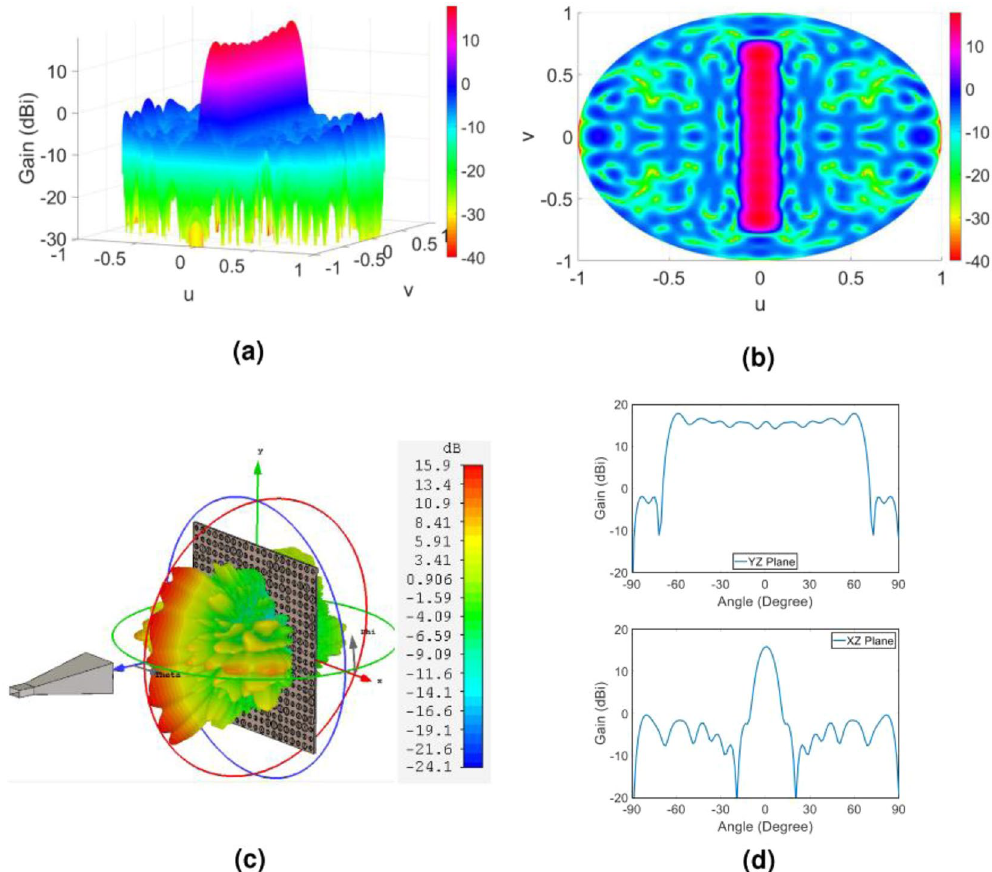
Figure 8. ( a ) Three-dimensional and ( b ) two-dimensional display of theoretical results of the object wave in the far field, ( c ) three-dimensional demonstration of the full wave simulation result of the object wave in CST software, ( d ) demonstration of the object wave in the two principal planes of the hologram. Note that the patterns demonstrated in ( d ) are related to the principal planes of YZ- and XZ-planes or u = 0 and v = 0,